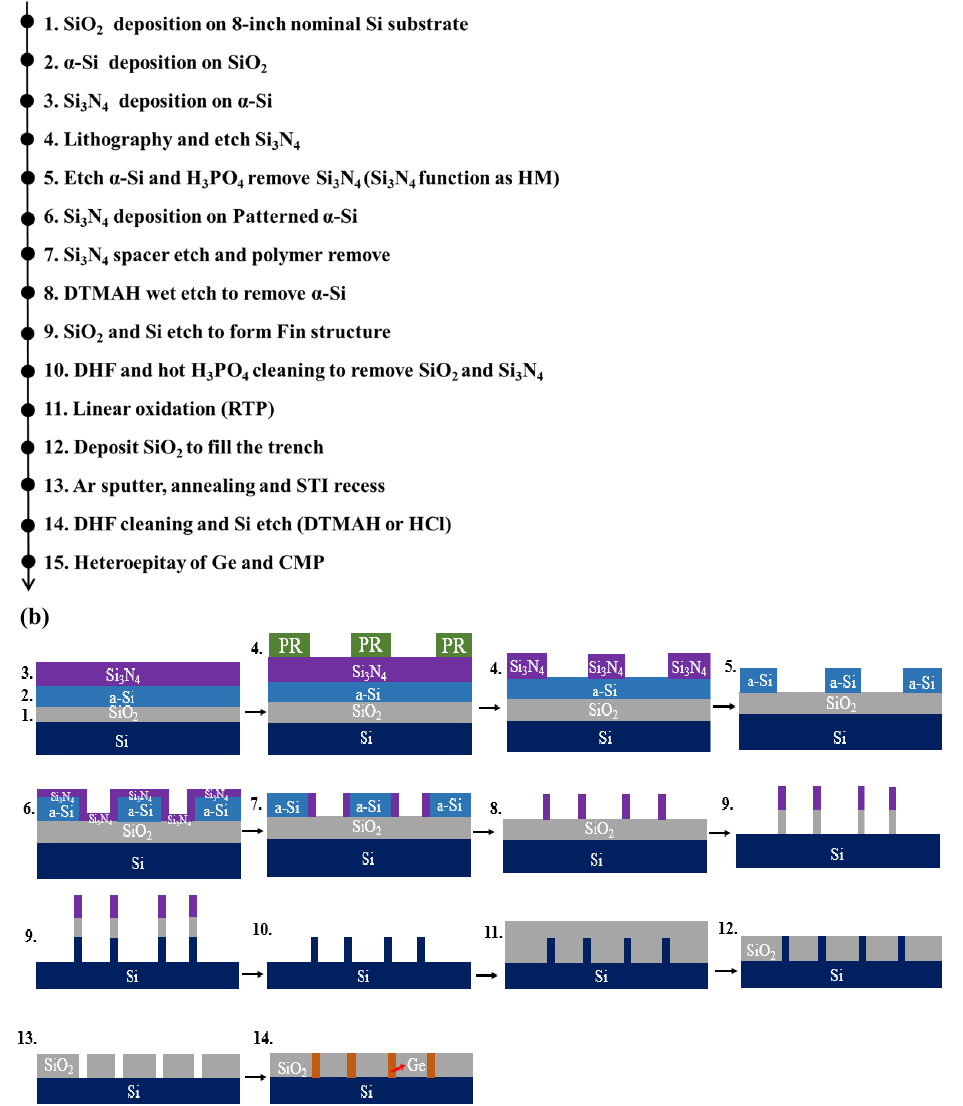
Figure 2. Process flow of the structures used in this research: ( a ) flowchart of the main steps and ( b ) corresponding schematic diagram for ( a ) (not to scale) .